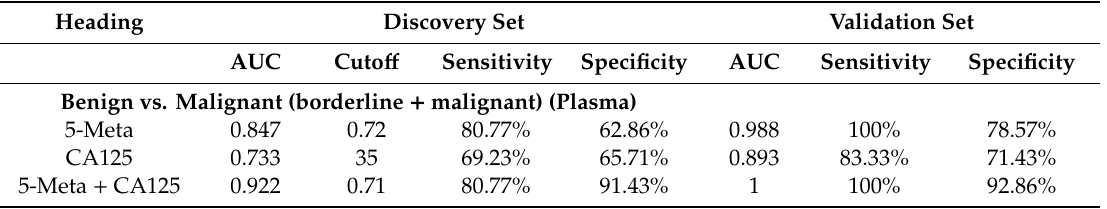
Table 4. Results of measurement of the plasma putative metabolite panel, CA125 or Both in the diagnosis of early-stage ovarian cancer from benign ovarian